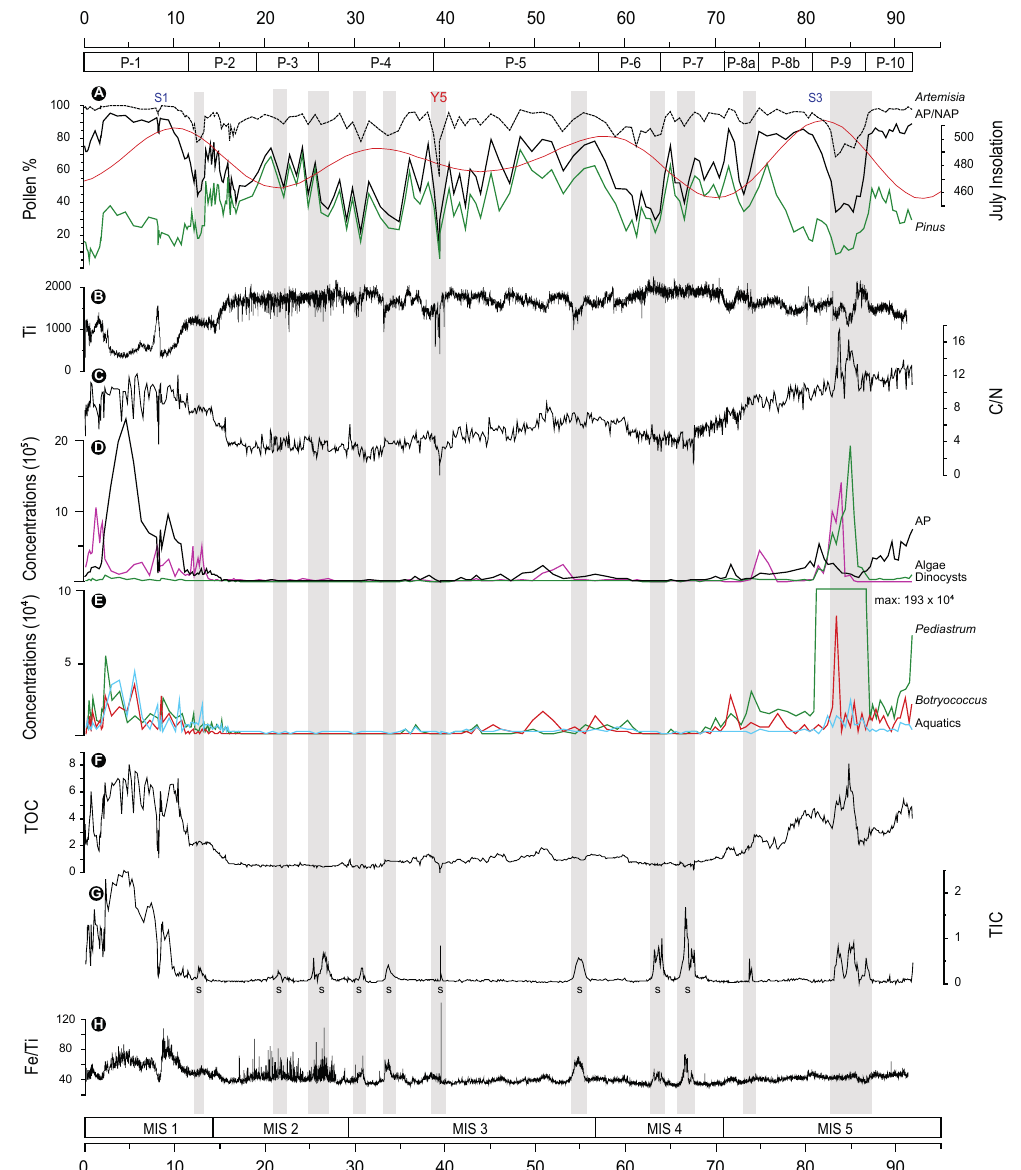
Fig. 5. Selected biological and geochemical proxies from Lake Prespa (core Co1215) plotted against age. (A) Artemisia (dashed line), AP / NAP (black), and Pinus (green) pollen percentages; mean July insolation at 40 ◦ N (Wm − 2 ; red) computed in AnalySeries 2.0 (Paillard et al., 1996; data from Laskar et al., 2004); sapropels (S1, S3); and Y5 tephra layer. (B) Titanium (Ti) counts; (C) atomic C / N; (D) concentra- tions ( × 10 5 ) of arboreal pollen (AP; black), green algae (green) and dinoflagellates (purple); (E) concentrations ( × 10 4 ) of aquatics (blue), Botryococcus (red) and Pediastrum (green). Note the difference in scale, (F) total organic carbon (wt%); siderite ( s ) peaks are marked; (G) total inorganic carbon (wt%); (H) iron/titanium (Fe / Ti). Shaded intervals correspond to carbonate peaks precipitated at Lake Prespa during the last